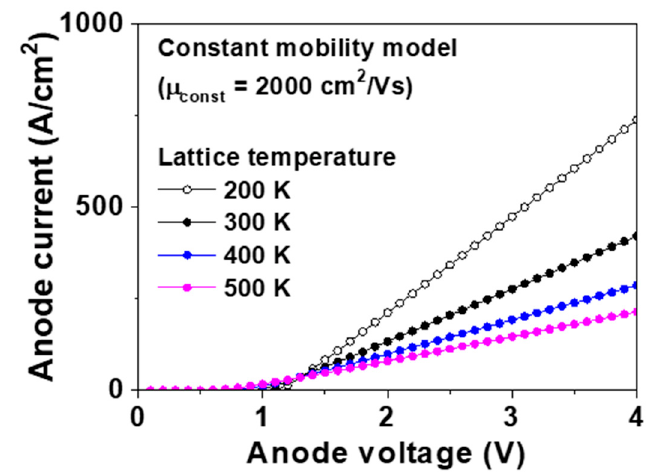
Figure 3. Forward current–voltage (I–V) characteristics of the p-type diamond pseudo-vertical Schottky barrier diode (SBD) simulated using the constant mobility model at 200, 300, 400, and 500 K. The metal work function, hole saturation velocity, and µ const were 5.65 eV, 2.7 × 10 7 cm / s, and 2000 cm 2 / Vs, respectively.